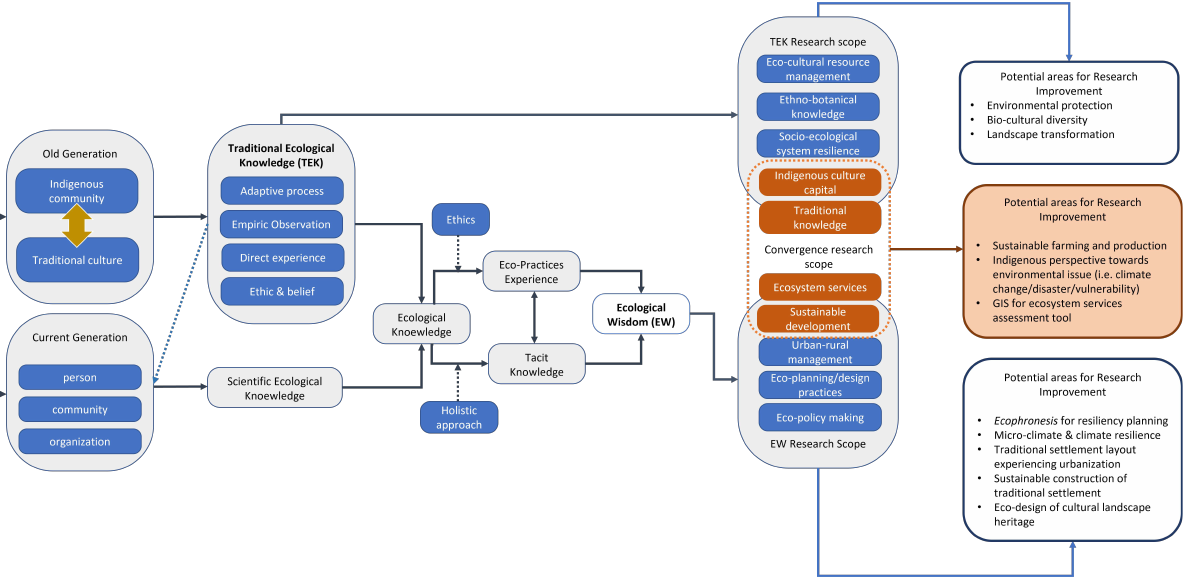
Figure 9. Conceptual framework of the TEK–EW relationship in cultural landscape